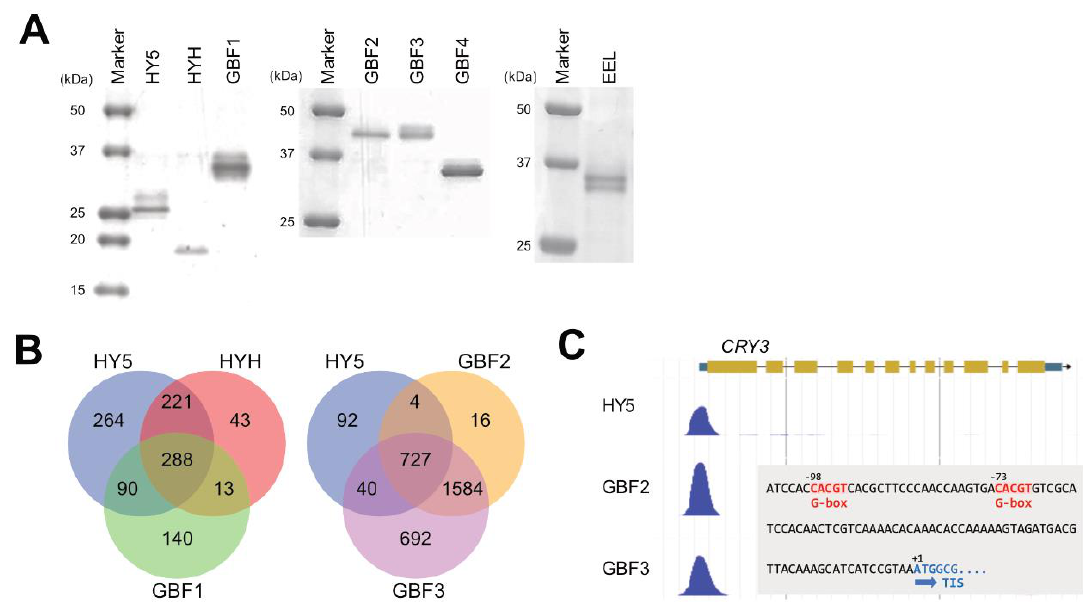
Figure 5. Comparison of physical binding sites identified by gDB-seq analysis among bZIP TFs. ( A ) Detection of recombinant proteins with an HA-tag at the N-terminal by SDS-PAGE gel electrophoresis. Recombinant proteins were synthesized in wheat germ extracts. ( B ) Overlap between genes with promoters possessing HY5-binding sites and genes with promoters possessing binding sites of HYH, GBF1, GBF2 or GBF3. ( C ) Nucleotide numbers are relative to the translation initiation site (TIS) (+1).